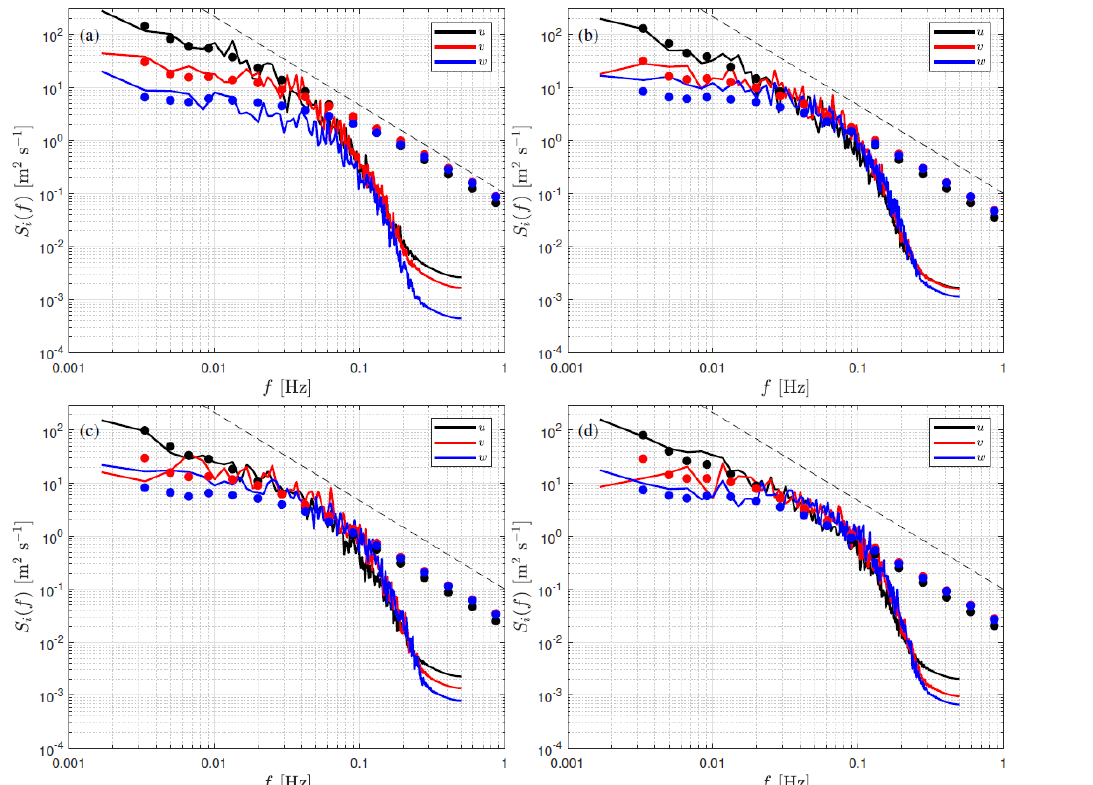
Figure 13. Neutral velocity spectra at 37 (a) , 103 (b) , 175 (c) , and 241m (d) . Markers indicate observations and the solid lines simulations. The dashed line represents a slope of − 5 /